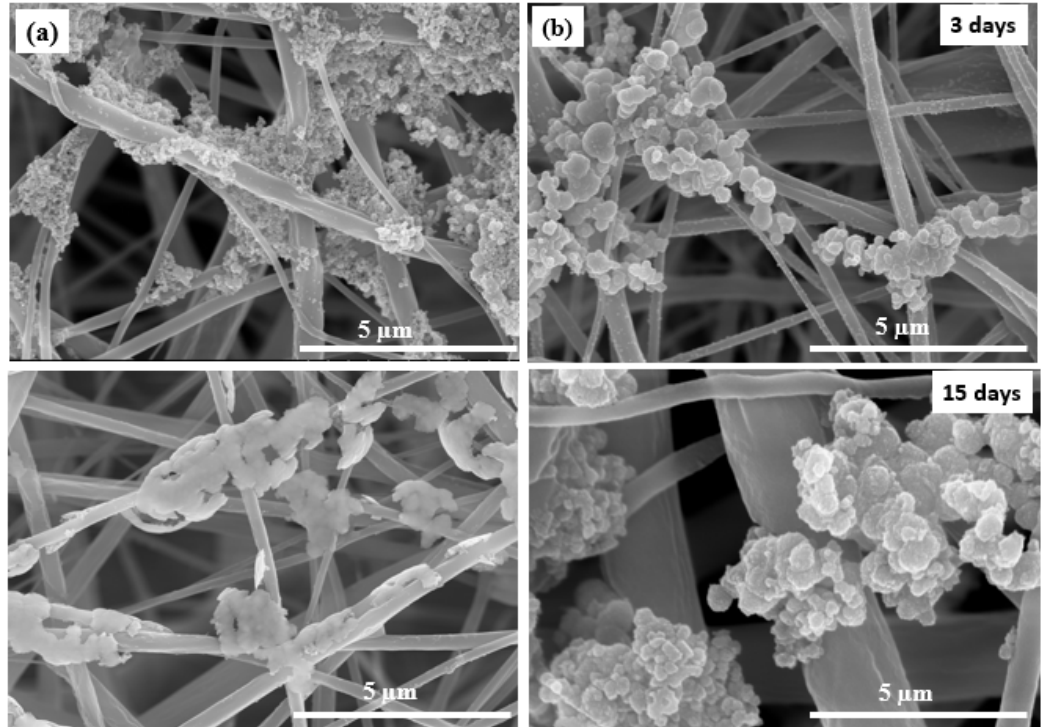
Figure 5. Biomineralization test shows FESEM images of mat morphology after SBF incubation for 3 and 15 days. ( a ) CA and ( b ) CA/Fe mats.